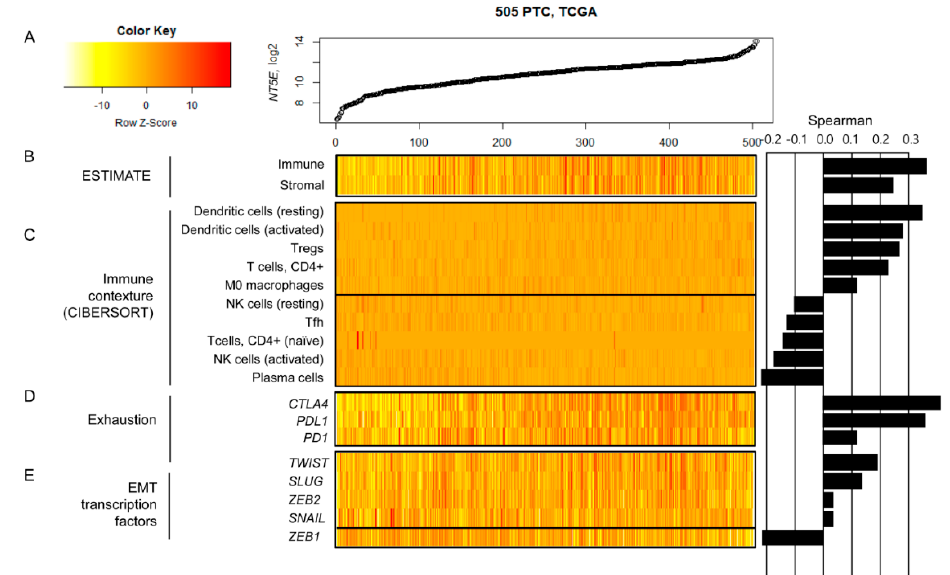
Figure 7. Relationship between CD73 ( NT5E ) mRNA expression and tumor microenvironment-related genes in papillary thyroid carcinoma data from The Cancer Genome Atlas (TCGA). ( A ) A total of 505 PTCs were sorted by their CD73 expression levels. ( B ) The ESTIMATE analysis shows a positive correlation between CD73 transcript levels and both immune and stromal scores. ( C ) In the CIBERSORT analysis, CD73 expression levels were positively correlated with the abundance of dendritic cells and Tregs, but were negatively correlated with transcript levels of natural killer (NK) cells and plasma cells. NT5E transcript levels were positively correlated with those of immune checkpoint genes ( D ) and epithelial-to-mesenchymal transformation (EMT) related genes ( E ).